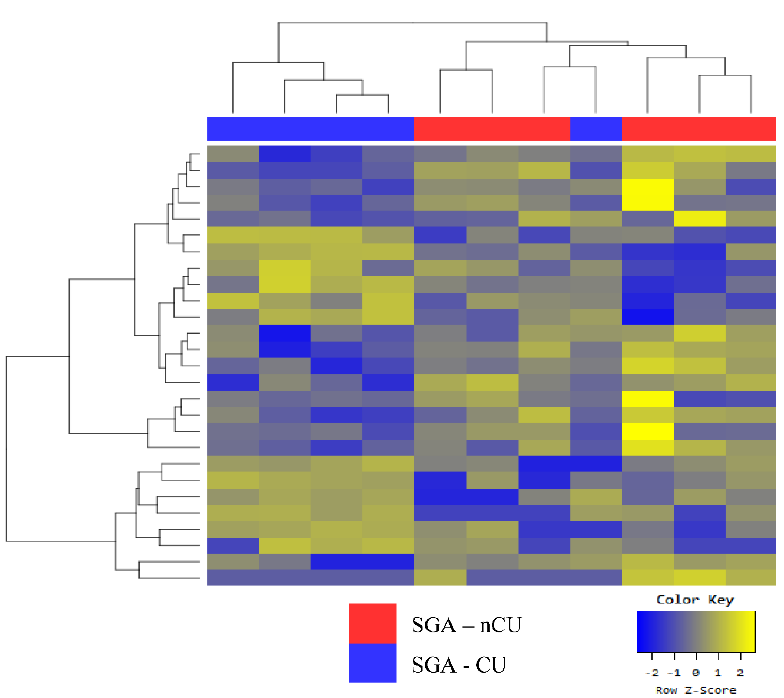
Figure 4. Heat map of the Z-scores of exosomal miRNAs for the SGA-nCU (n = 6) and SGA-CU (n = 5) groups. Table 6. Exosomal miRNA profiles of the SGA-nCU and SGA-CU groups. ( a ) Fold change in exosomal miRNA expression of the SGA-nCU group compared with the SGA-CU group. ( b ) miRNAs showing similar expression trends between SGA-nCU and SGA-CU, and between SGA-nCU and AGA.